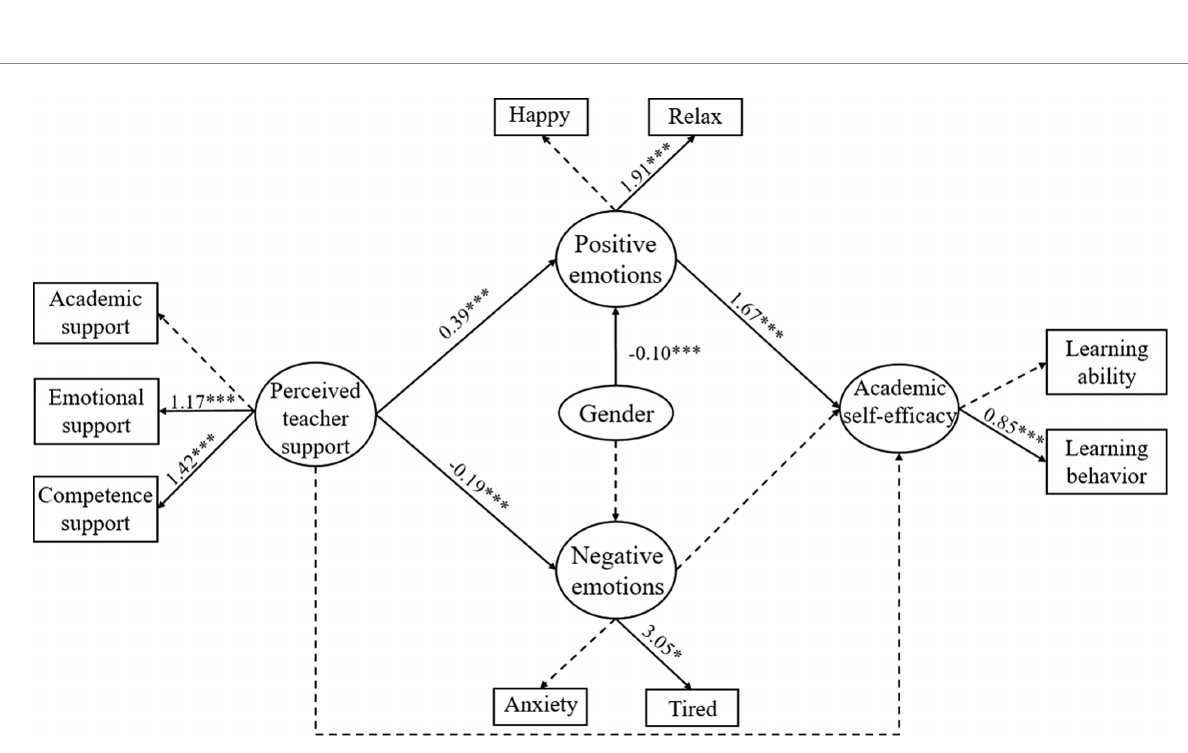
FIGURE 2 SEM of academic emotions as mediators. The coefficients shown are standardized path coefficients. A solid arrow represents a significant path, and a dotted arrow represents an insignificant path (* p < 0.05, *** p <